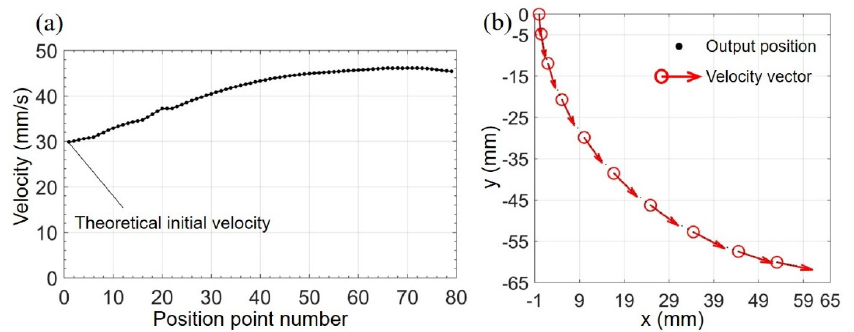
Figure 11. Output velocity of the moving joint. ( a ) Variation in the output velocity of the moving joint at the feature points. ( b ) Velocity vector diagram.